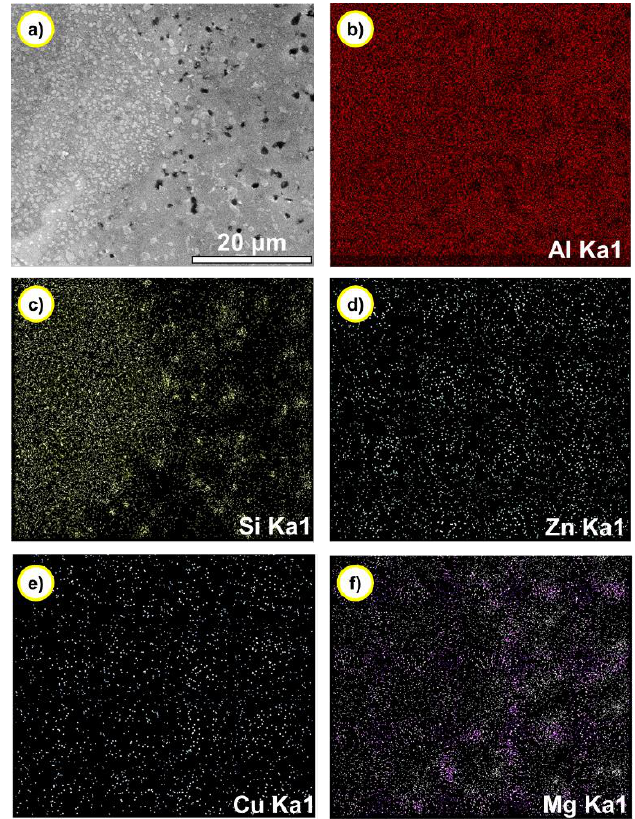
Figure 6. The distribution of elements in gradient composition alloy tested by plane scan of EDS. ( a ) Microstructure, ( b ) Al, ( c ) Si, ( d ) Zn, ( e ) Cu, and ( f ) Mg.